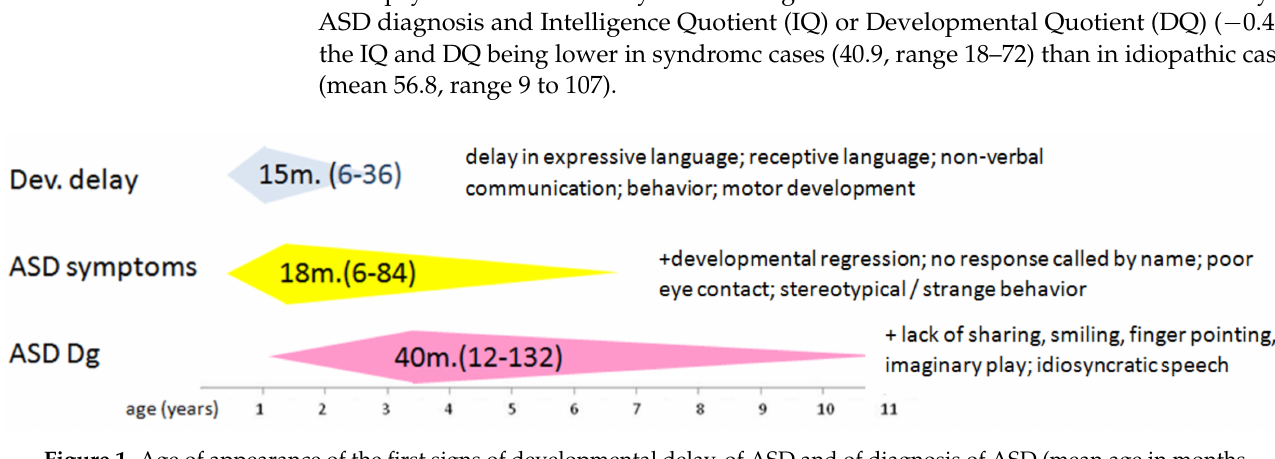
Figure 1. Age of appearance of the first signs of developmental delay, of ASD and of diagnosis of ASD (mean age in months (min-max). The first most common signs and symptoms of developmental delay and ASD observed by parents, and also by physicians at ASD diagnosis are added on the right of each step. Each next step includes also the preceding